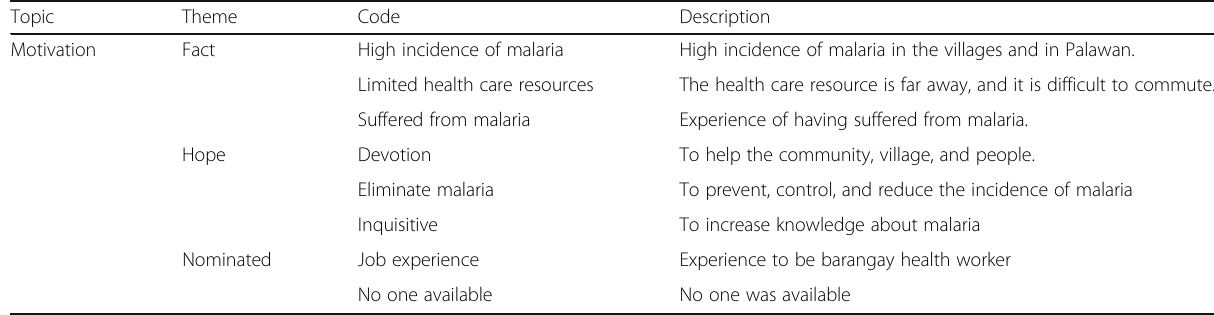
Table 4 Analytical framework of perception of the past (motivation)